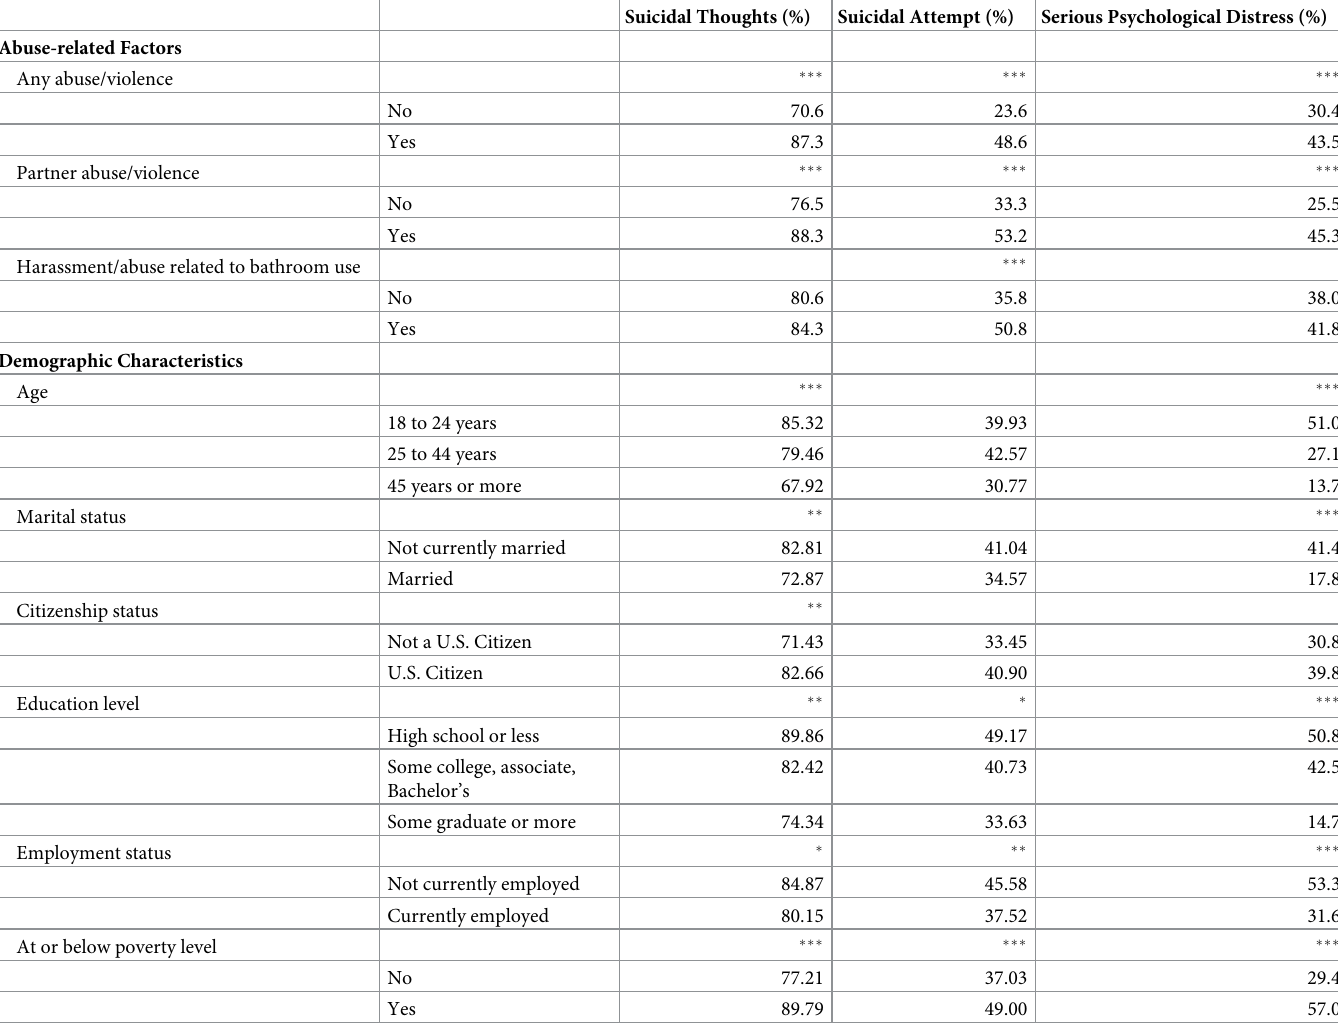
Table 2. Association between sample characteristics and mental health outcomes of suicidal thoughts, suicidal attempts, and serious psychological